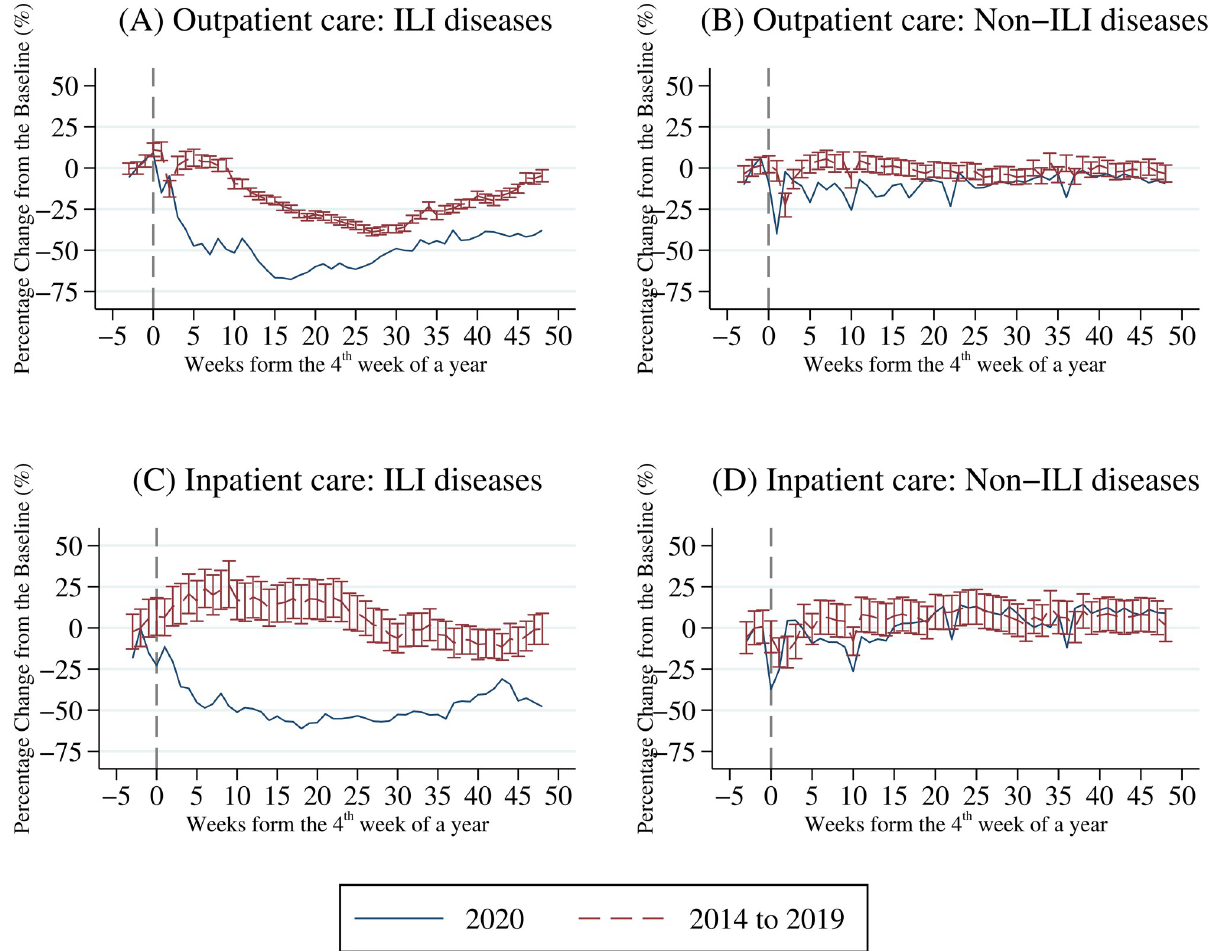
Fig 2. Percentage change in number of outpatient visits/inpatient admissions. A: Outpatient care: ILI diseases. B: Outpatient care: Non-ILI diseases. C: Inpatient care: ILI diseases. D: Inpatient care: Non-ILI diseases. Sample period is 2014–2020. The solid line represents the trend in 2020, and the dashed line denotes the average across 2014–2019 with a 95% confidence interval (error bar). Since the first confirmed COVID-19 case was announced in the 4 th week of 2020 (i.e. the week of January 21 st ), the vertical line in the graph separates that week from the following weeks. The vertical axis of this figure stands for the percentage change in the number of outpatient visits (inpatient admissions) from the baseline weeks. We use the number of outpatient visits (inpatient admissions) in the second week of each year as the baseline. (IRR = 0.87, 95% confidence interval [CI] 0.84 to 0.90). Furthermore, the estimates in Column (4) of Panels B and C show that ILI visits saw a much larger decline (i.e., 38% decrease, IRR = 0.62) than non-ILI visits (i.e., 10% decrease, IRR = 0.9). Columns (5) to (8) display the DID estimates for inpatient care. Column (8) of Table 2 pro- vides our preferred estimates. The estimate in Column (8) of Panel A indicates that the COVID-19 outbreak reduced total inpatient admissions by 4% (IRR = 0.96, 95% CI 0.90 to 1.01). This estimate is only one-third of the decline in outpatient care. The estimates in Col- umn (8) of Panels B and C show the results for ILI admissions and non-ILI admissions, respec- tively. Compared to the trend in previous years, the number of ILI admissions declined by 40% (IRR = 0.6, 95% CI 0.54 to 0.68) during the pandemic period in 2020 (see Panel B). In contrast, there was only a negligible decrease in inpatient admissions for non-ILI diseases (see Panel C).